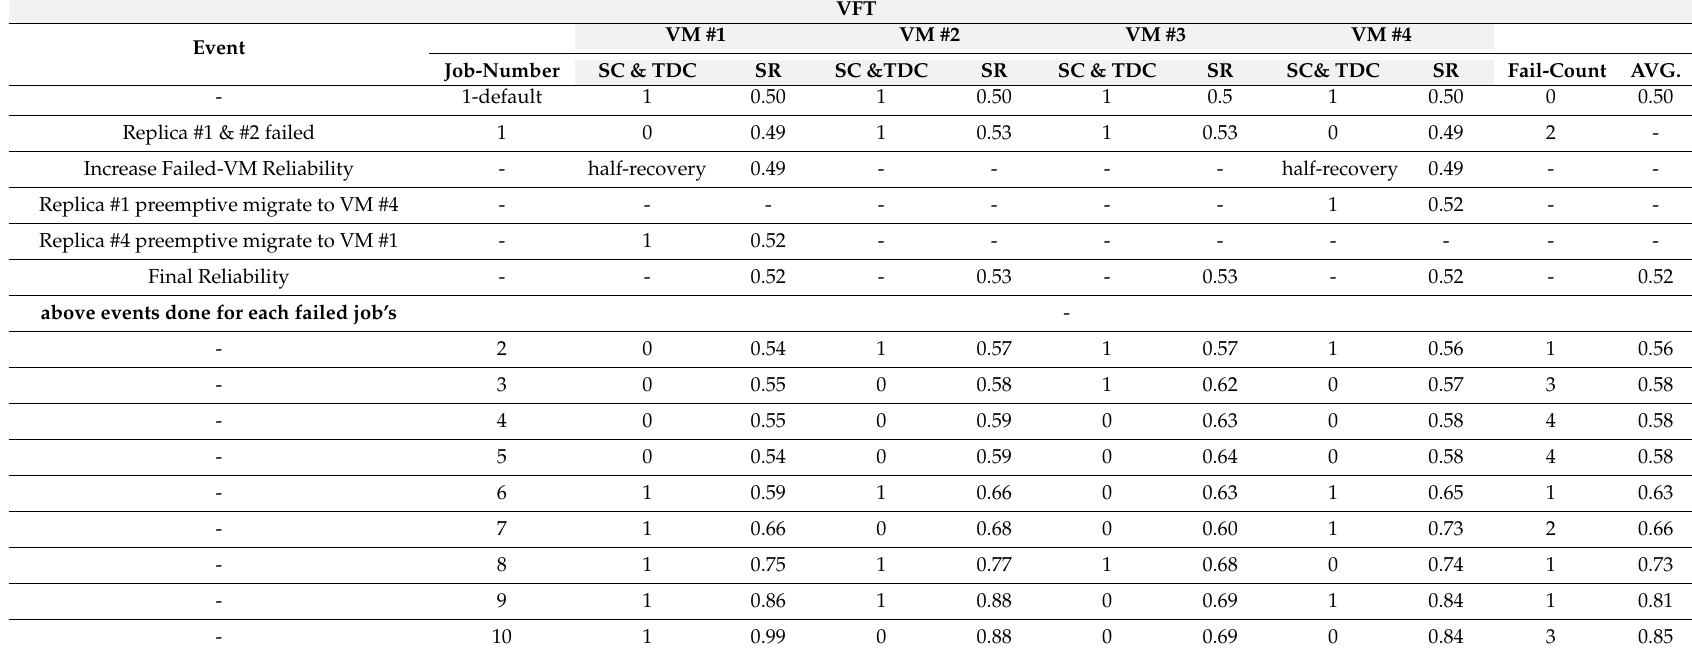
Table 7. Results of simulating VFT in